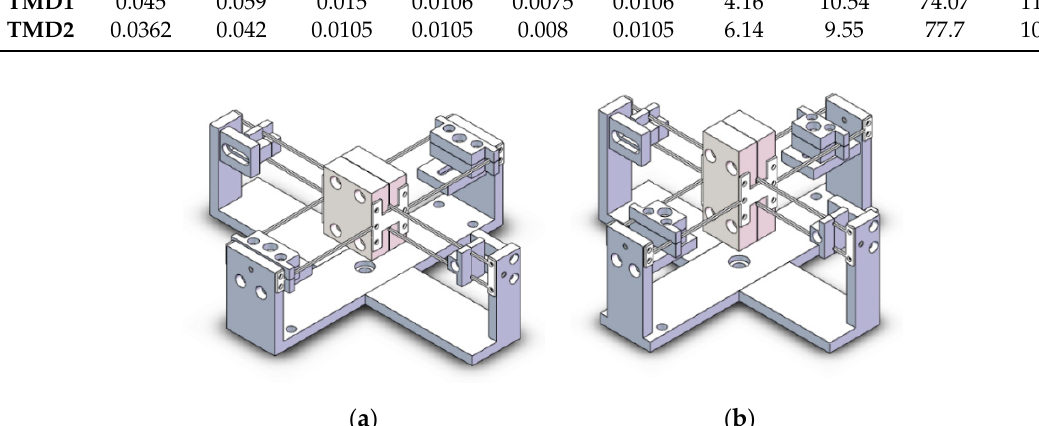
Figure 11. CAD view of TMD. (a) TMD1; (b) TMD2.